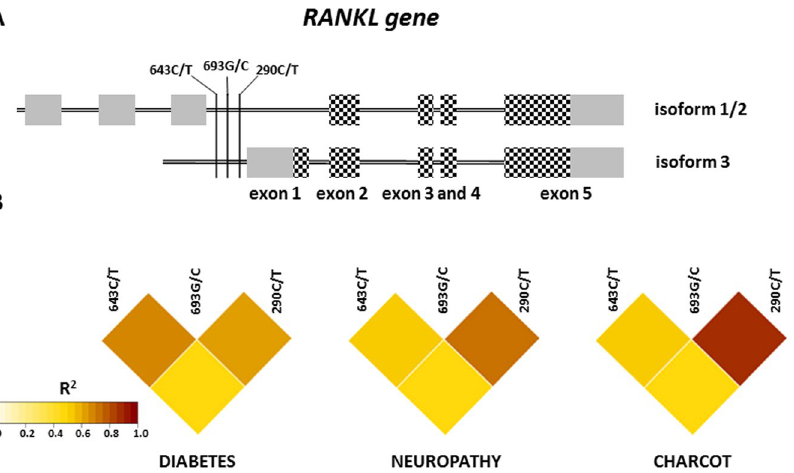
Figure 3. Linkage disequilibrium analysis for selected polymorphisms in the RANKL gene. ( A ) Schematic representation of the RANKL gene with position of studied polymorphisms. Exons are marked as boxes, with coding sequence marked as chessboard. ( B ) Linkage disequilibrium heat-maps basing on the r 2 value, calculated for each pair. Color intensity corresponds to higher r 2 values according to the legend in the bottom left